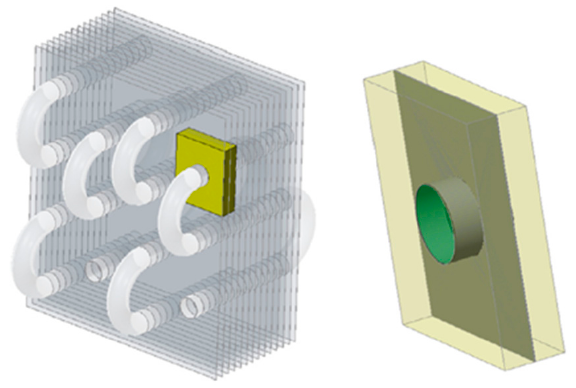
Figure 15. Elementary control volume on the refrigerant side (green, right side ) and the air side (yellow, left side ) [87].